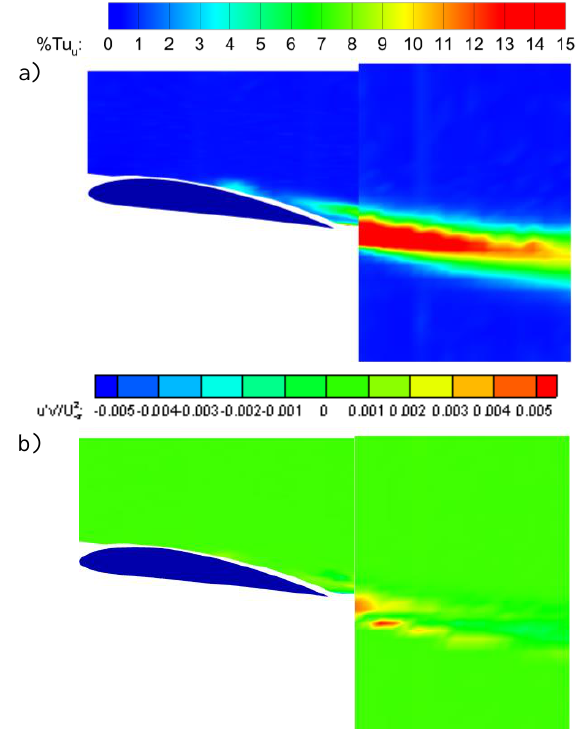
Fig . 2. u/U ∞ at Re=5x10 4 and α=8º for partial flexible wing (and z/s=0.4) .